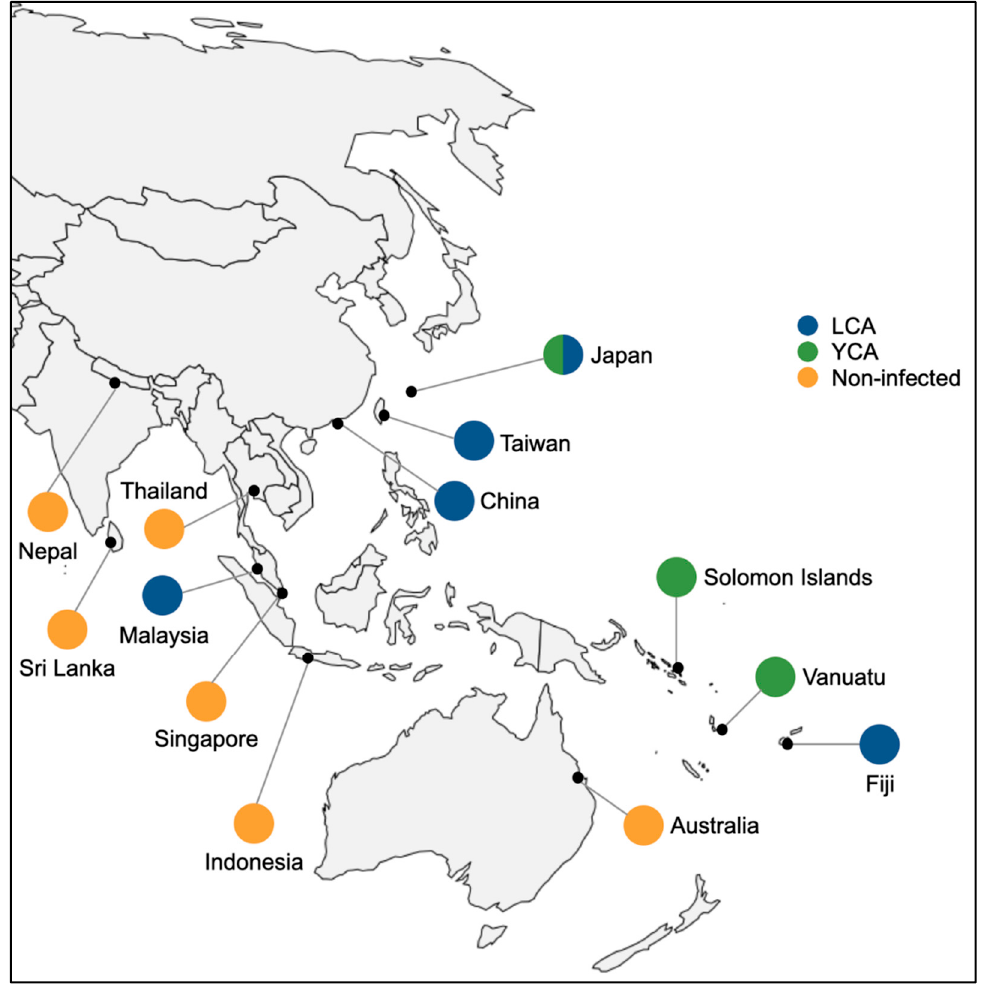
Figure 1. Map showing an overview of deformed wing virus status in two widespread invasive ant species, Paratrechina longicornis (longhorn crazy ant, LCA) and Anoplolepis gracilipes (yellow crazy ant, YCA), across the Asia–Pacific region.